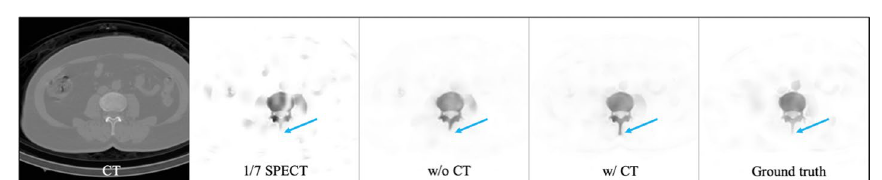
Fig. 8 Visual results of w/ and w/o CT as input of the proposed model. Enhanced image with combined CT input preserved more structure than those without CT input and 1/7